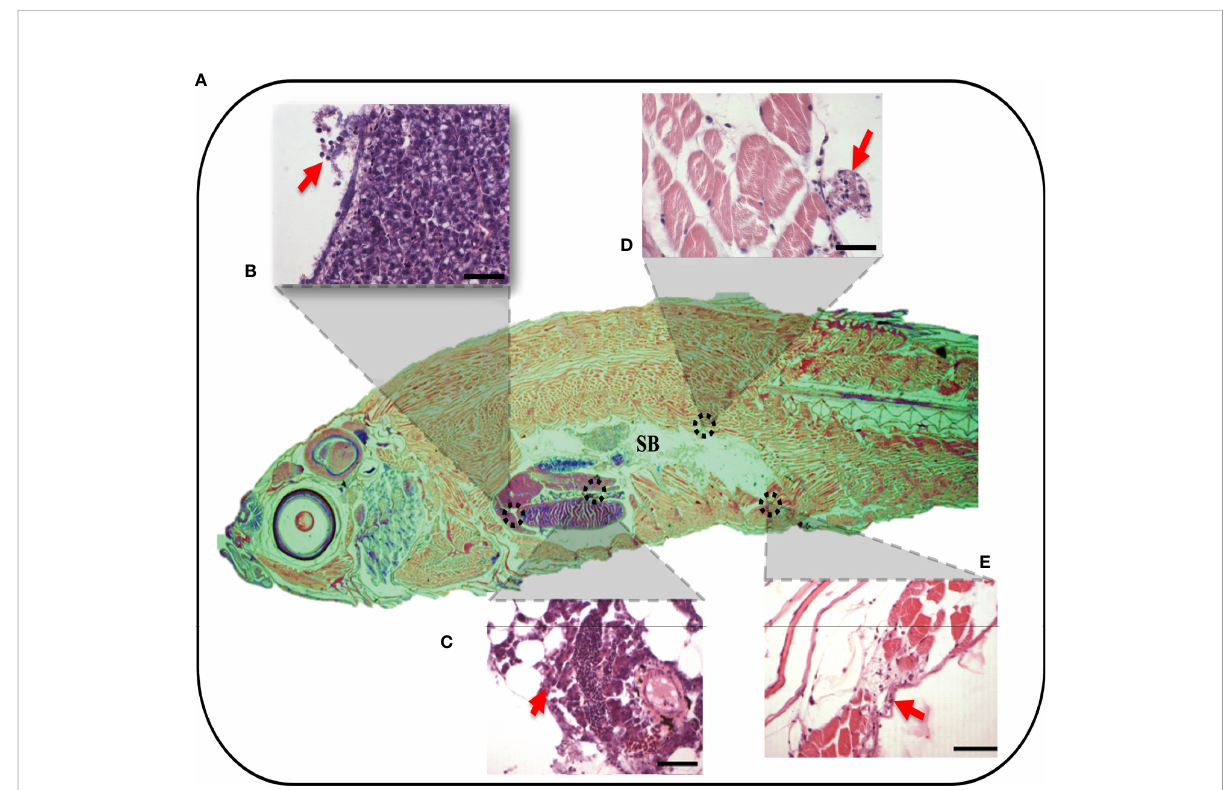
FIGURE 3 Whole organism imaging of H&E-stained adult zebra fi sh enables the visualization of histology-like cross-sections. (A) Representative sagittal cross-section of adult wild-type zebra fi sh resulting after 4h post-injection of 3.5% l -CGN by i.p. (B – E) The histopathological lesions recorded on selected tissues. (B) The projection showing detail of liver damage with the arrow indicating a leukocytes in fi ltration in the hepatic fracture caused by the induced swelling. (C) Pancreas with in fl ammation and recruited leukocytes present in the connective tissue capsule. (D) Dorsal muscle fi bers at the edge of the peritoneal cavity showing muscular edema, the arrows highlight the in fi ltrating cells. (E) Ventral muscles denoting a clear in fl ammatory process on top of the muscularis and besides muscle packs. (n = 10). For reference the swim bladder-SB is indicated. Scale bar 50